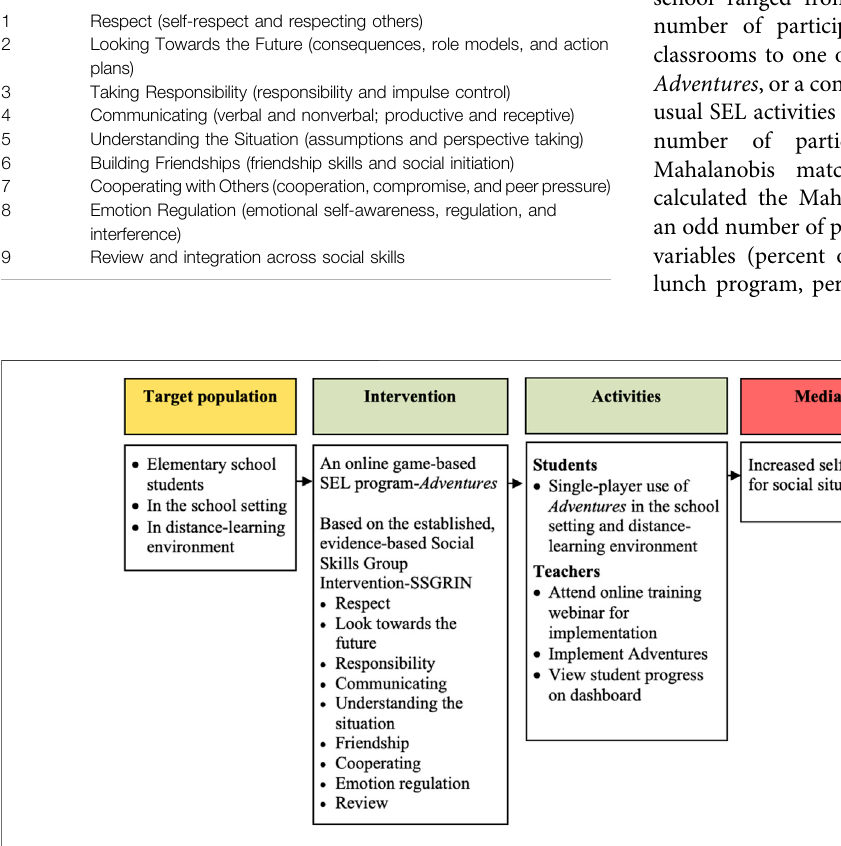
FIGURE 1 | Logic model for the Adventures Aboard the S.S. GRIN